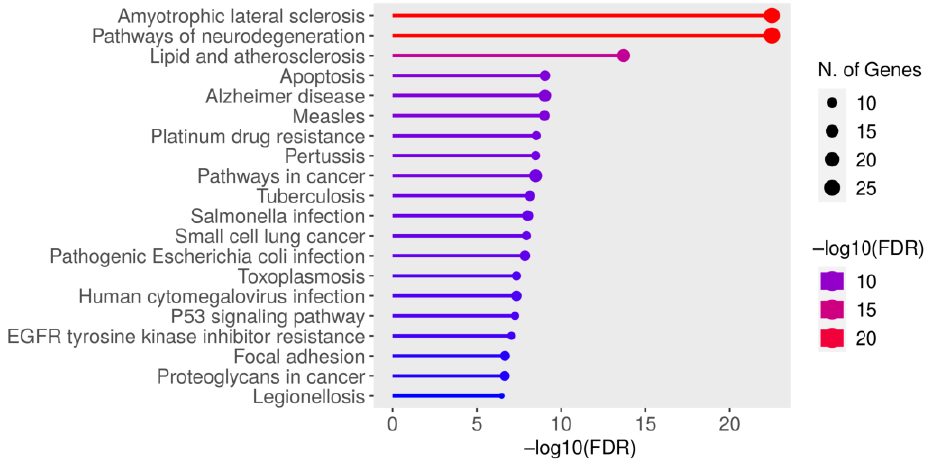
Figure 4. The GO analysis of IPA-predicted SOD1-ALS pathway molecules by ShinyGO. The GO analysis identified amyotrophic lateral sclerosis and neurodegeneration signaling as the key path- ways.